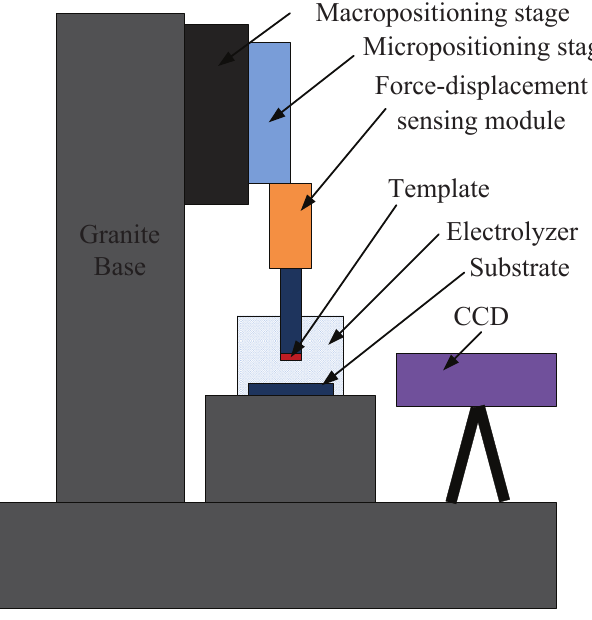
Figure 1. The schematic of the approaching